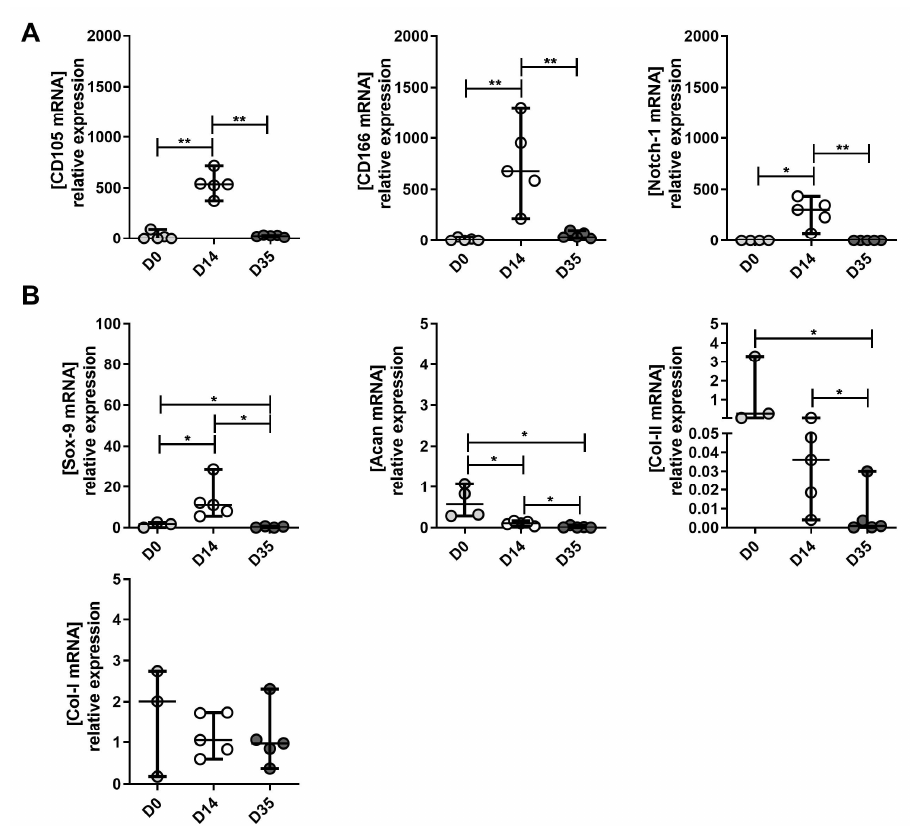
Figure 5. The expression of MPC, chondrocyte and hypertrophic chondrocyte markers between mild OA-derived tissue (D0), expanded (D14) and re-differentiated cells (D35). ( A ) Changes in mRNA expression levels of CD105, CD166 and Notch 1 (MPC markers) between D0, D14 and D35. ( B ) The changes of mRNA expression levels of Sox9 (MPC marker), Acan and Col II (chondrocytes markers) and Col I (hypertrophic chondrocytes marker) between D0, D14 and D35. D0 is used as the control to normalize expression levels. * p < 0.05, ** p < 0.01, non-parametric Kruskal–Wallis and Mann–Whitney test were